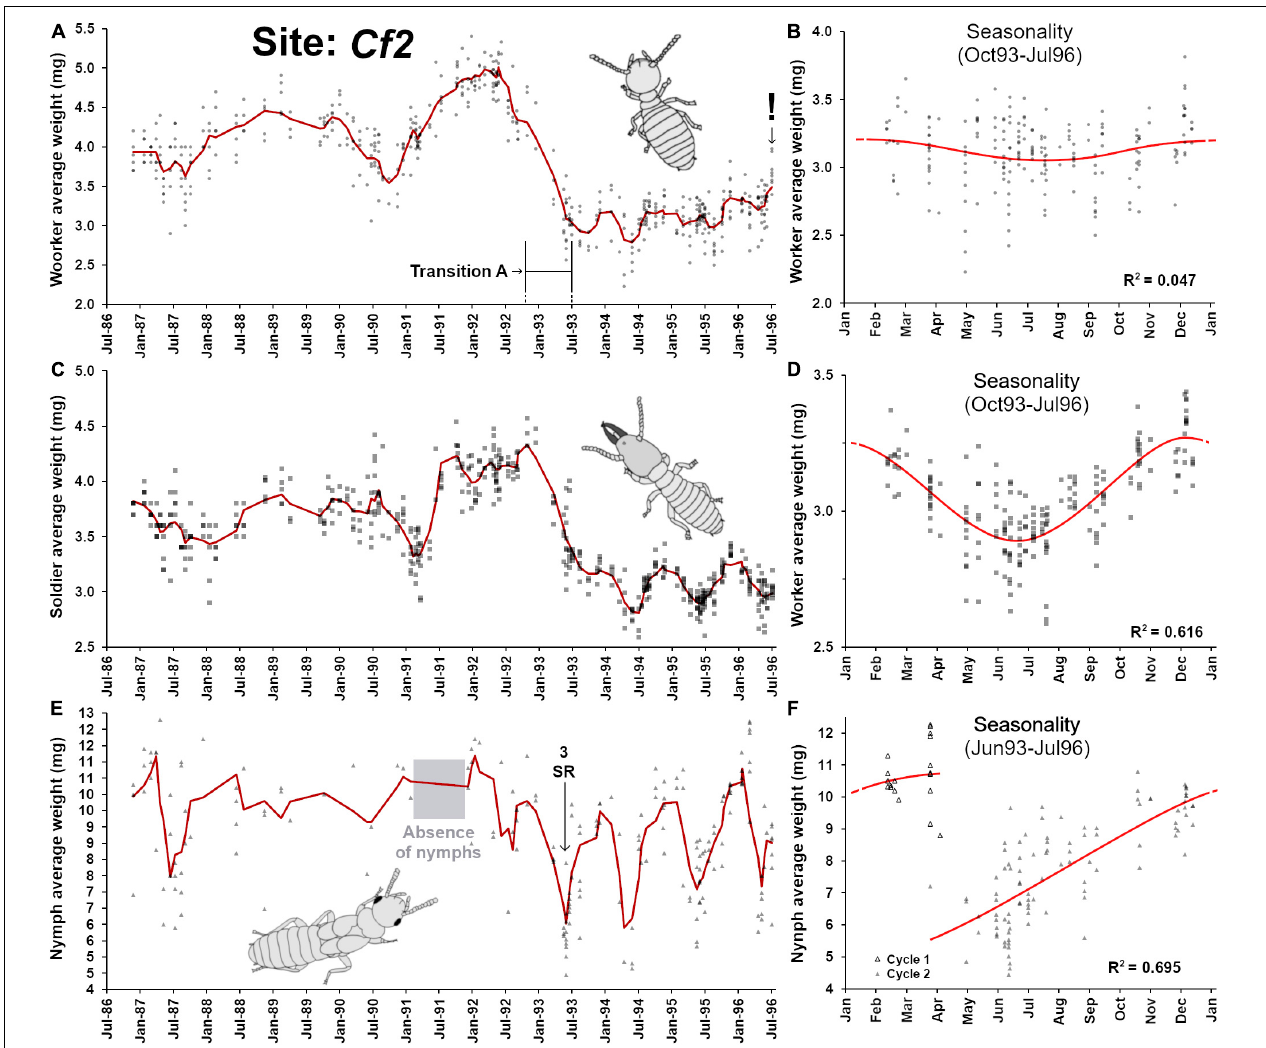
FIGURE 4 | Colony demographic changes for Coptotermes formosanus at site Cf2 . Each data point represents an average caste weight from a field trap. For the 1986–1996 demographic trends of each caste, the red line represents the rolling average function (period = 3). (A) Workers’ average weight between 1986 and 1996. (B) Workers’ average weight seasonality, following a weak annual sinusoidal function ( F 2 , 201 = 4.89, p = 0.008, R 2 = 0.047). (C) Soldiers’ average weight between 1986 and 1996. (D) Soldiers’ average weight seasonality, following an annual sinusoidal function ( F 2 , 201 = 161.4, p < 0.001, R 2 = 0.616). (E) Nymphs’ average weight between 1986 and 1996. (F) Nymphs’ average weight seasonality, with an annual growth that follows a polynomial function ( poly3 , F 3 , 115 = 87.2, p < 0.001, R 2 = 0.695). “Transition A” represents a major reproductive shift within the colony, with a hiatus in reproduction, followed by the re-establishment reproduction via secondary reproductives ( =